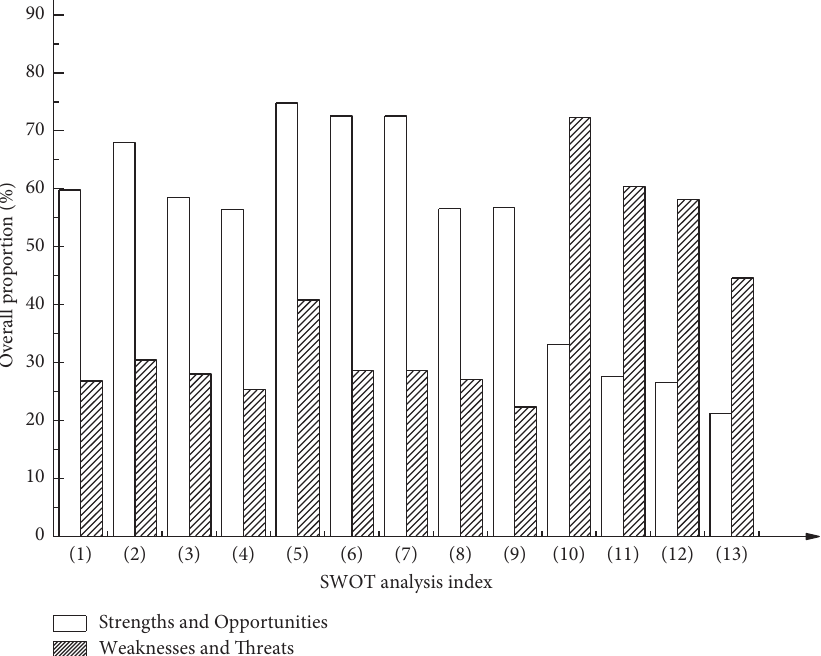
Figure 4: SWOT analysis of teacher development under the MOOC online learning